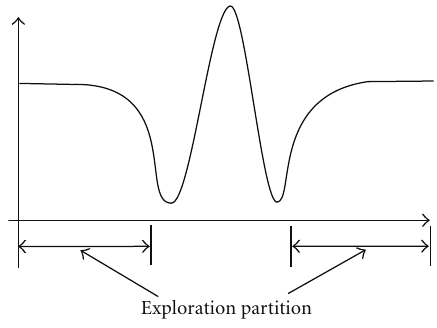
Figure 9: Visualization of a simple target density distribution with corresponding exploration partition